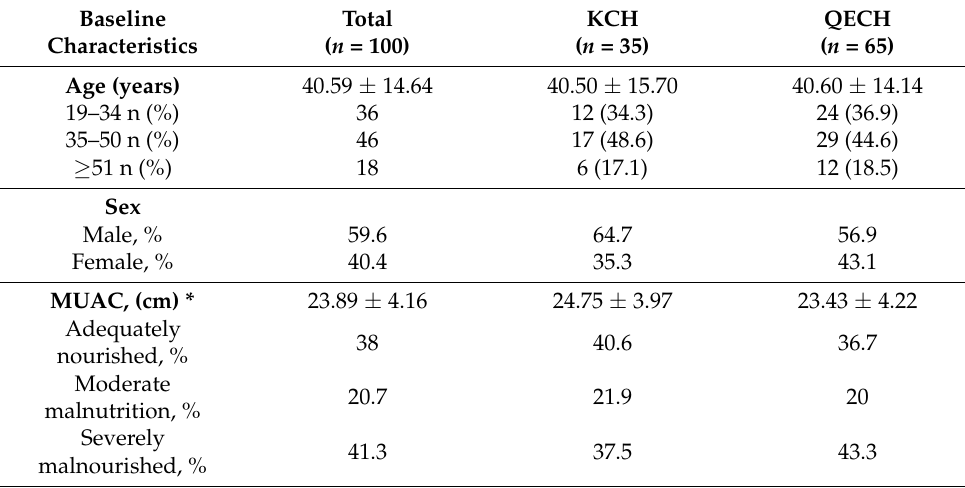
Table 1. The demographics and anthropometrics for all adult patients.